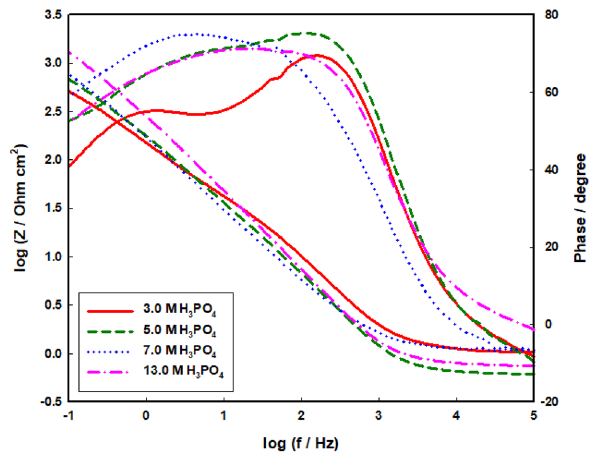
Figure 6. Bode plots of Mo in different concentrations of H 3 PO 4 at 298 K.